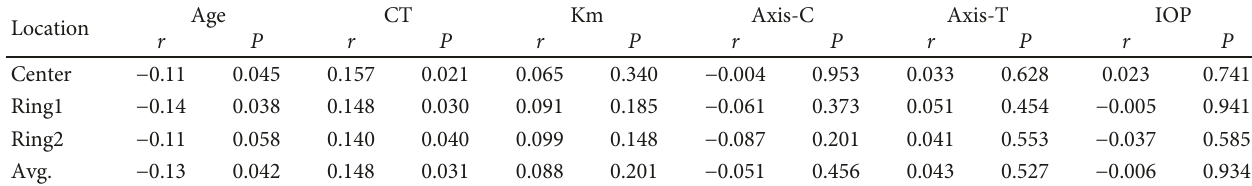
Table 3: Correlations between corneal epithelial thickness and some parameters.